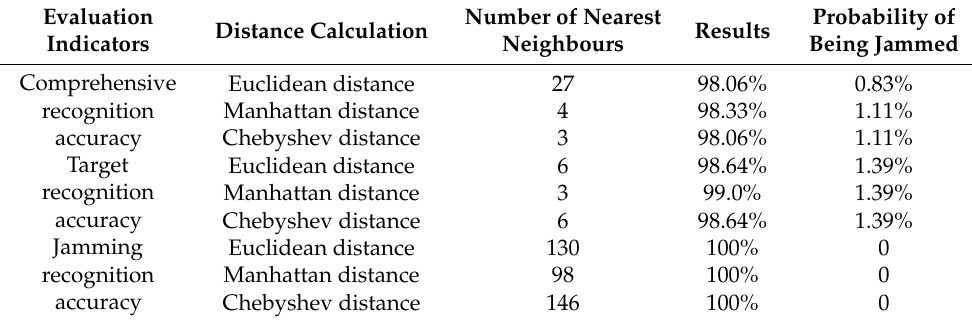
Table 2. Optimal recognition results of different